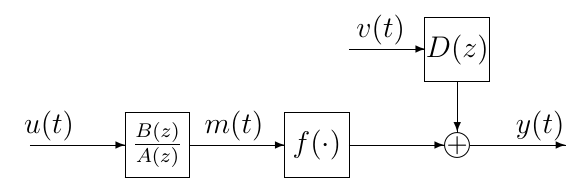
Figure 1. The Wiener nonlinear OEMA